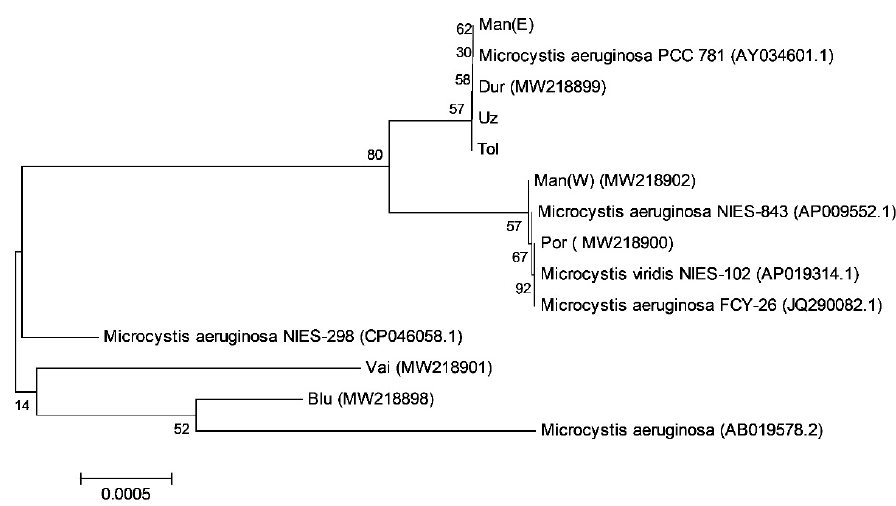
Figure 8. Neighbor-joining phylogenetic tree constructed from nucleotides sequences from direct sequencing of PCR products and mcyB marker retrieved after BLAST search in NCBI database with the accession number presented. Bootstrap values are shown at branch points (percentage of 1050 resampling). Legend: Tol—Reservoir Izvornik 2 (=Tulumdere), Dur—Lake Durankulak, Por—Reservoir Poroy, Man (E)—Reservoir Mandra (site East), Man (W)—Reservoir Mandra (site West), Vai—Lake Vaya, Uz—Lake Uzungeren, Blu—Reservoir Sinyata Reka (=Blue River). For the identical sequences (IS), obtained during this study, only one accession number received from NCBI is provided in each cluster or subcluster. The IS from Durankulak, Mandra East, Izvornik 2 and Uzungeren have accession number MW218899.